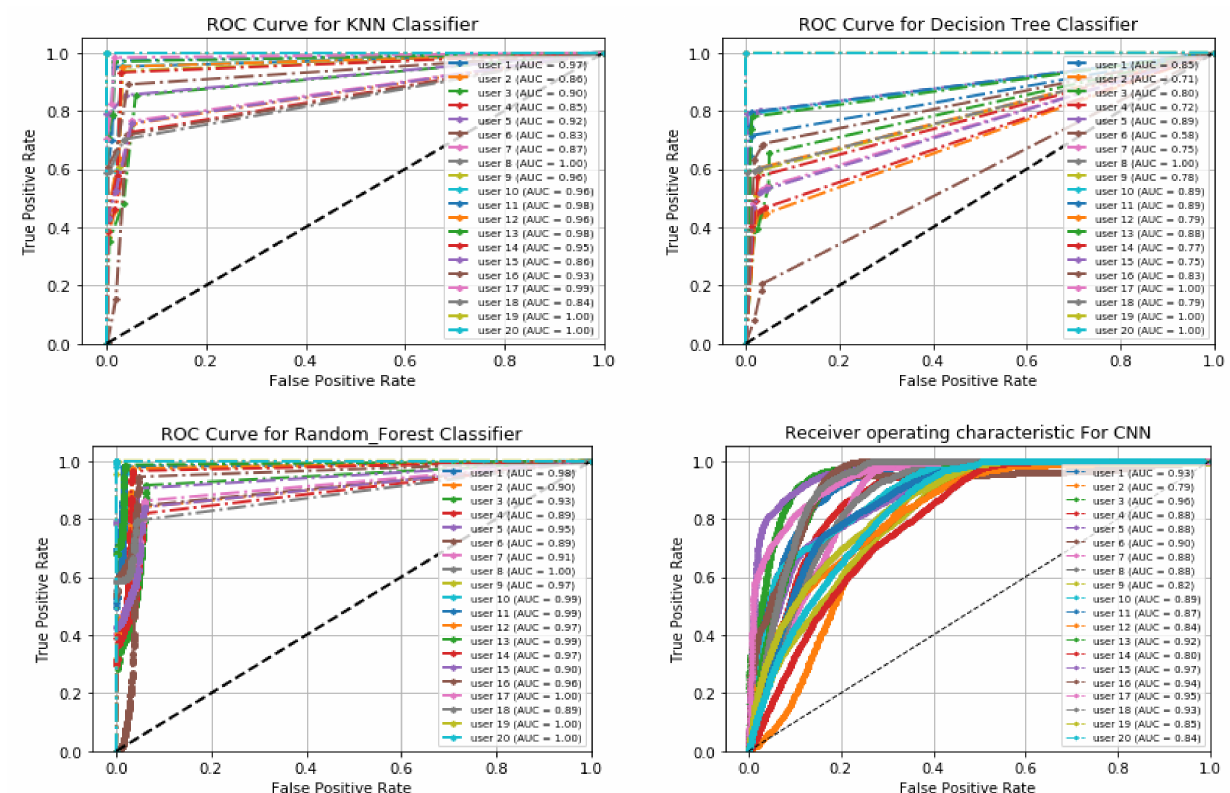
Figure 16. ROC curves for anomaly detection—single point-and-click